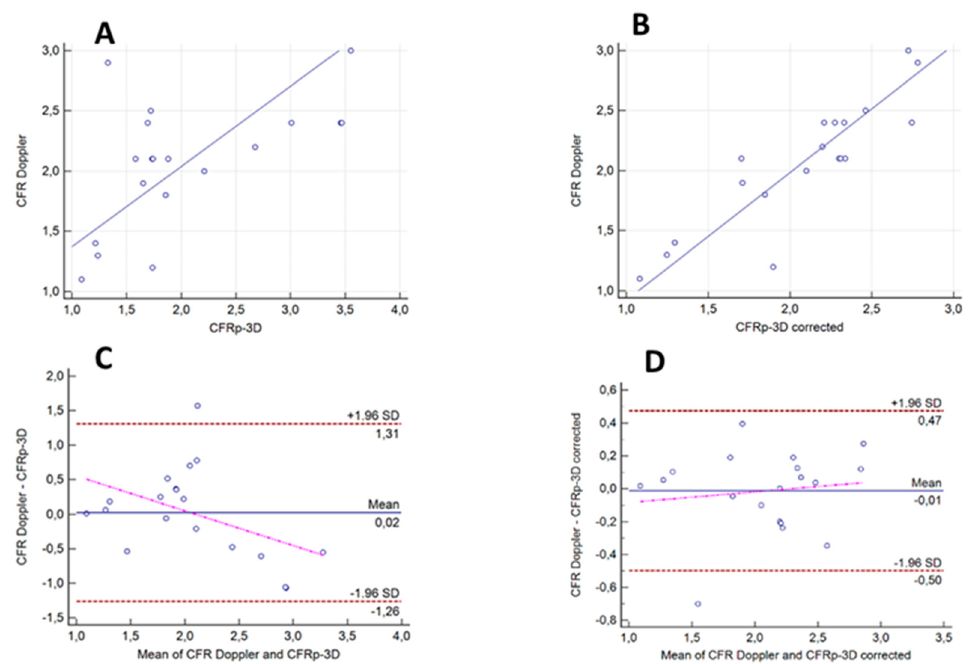
Figure 4. Correlations and agreements between calculated CFR p-3D values without and with hydrostatic offset correction, and the measured Doppler CFR values. ( A , B ) Correlations between the calculated CFR p-3D values without and with hydrostatic offset correction and the measured Doppler CFR values: r = 0.57, p = 0.01, and r = 0.89, p < 0.0001, respectively. ( C , D ) Bland-Altman analysis of the agreement between the calculated CFRp-3D values without and with hydrostatic offset correction and the measured Doppler CFR values.